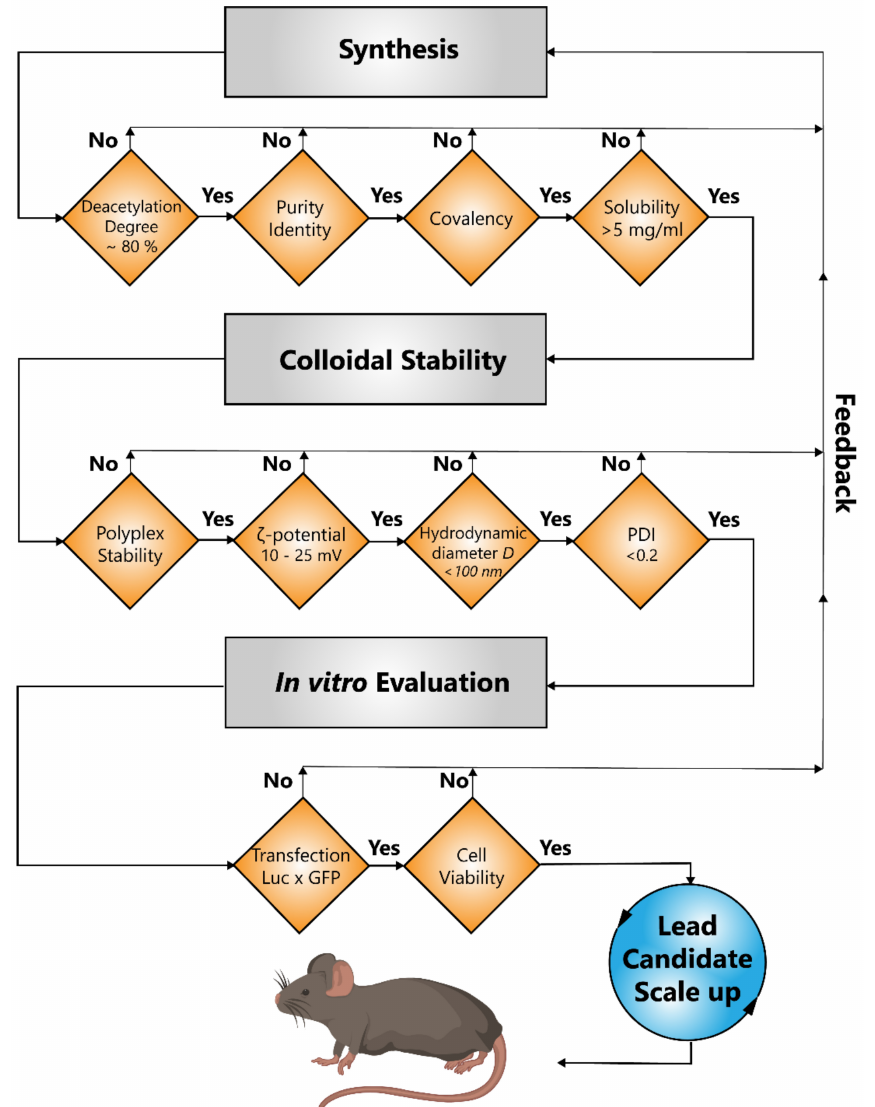
Figure 1. Screening cascade of depolymerized chitosan (dCS)–PEI–based delivery vectors. Identifica- tion of a lead candidate was guided by defined chemical properties of the polymer, the indicated physicochemical characteristics of the polyplexes to be met, and biological performance in vitro (i.e., transfection efficiency and cytotoxicity) using the hepatic HuH–7 cell line. Following synthesis, the resulting polymer was chemically identified by 1 H NMR and tested for covalent bonding by 2D–diffusion ordered spectroscopy (DOSY) NMR. Only compounds with a solubility of >5 mg/mL were selected for further characterization. Colloidal stability was assessed after DNA complex- ation. In vitro performance was evaluated by using two reporter gene vectors (n.CAGLuc2 and n.CAG.GFP1). The lead candidate is characterized by favorable safety and transfection profiles in vitro allowing for in vivo evaluation of transfection